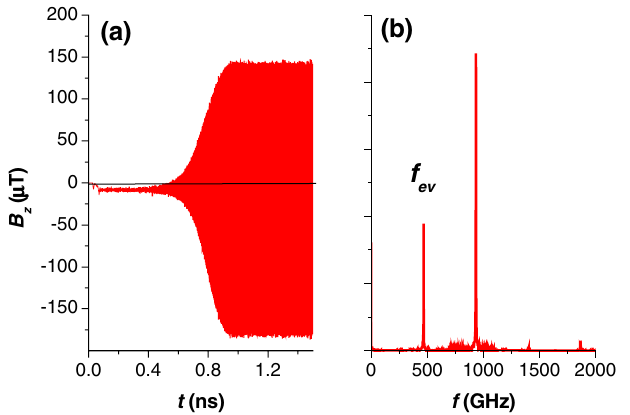
(cid:2) t (cid:4) and (b) the correspond- z